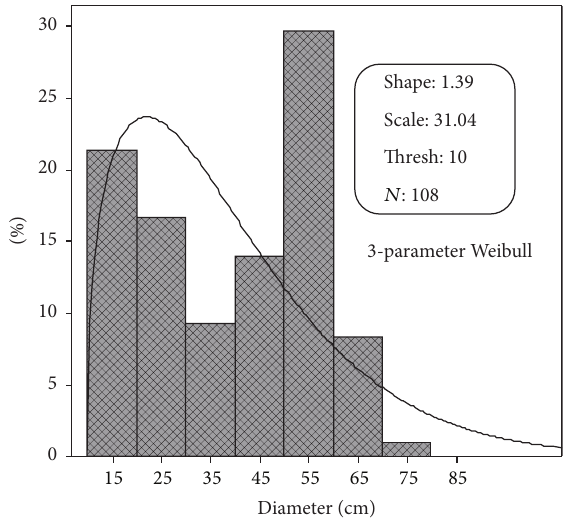
Figure 2: Diameter class-size distribution in the Guinean